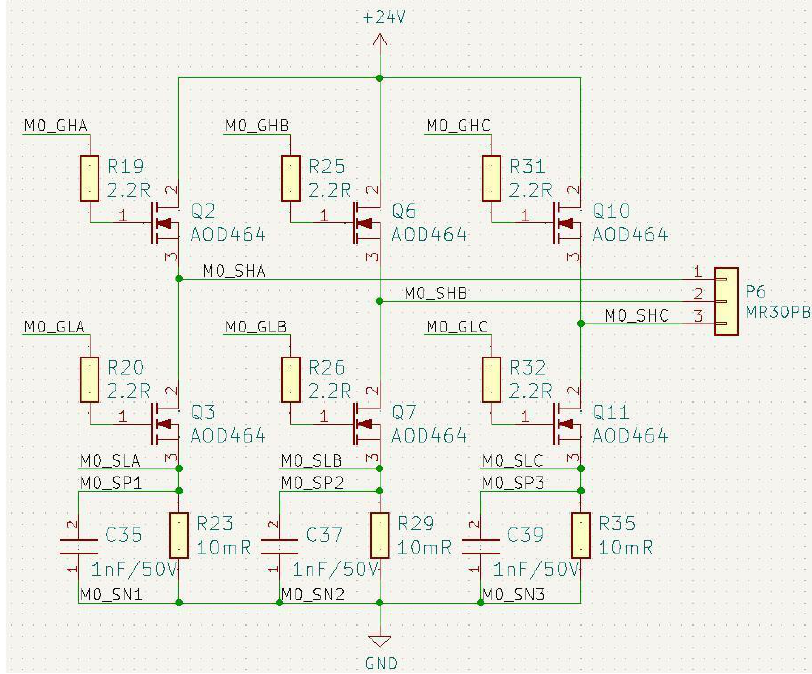
Figure 9. Schematic diagram of the three-phase full-bridge circuit.